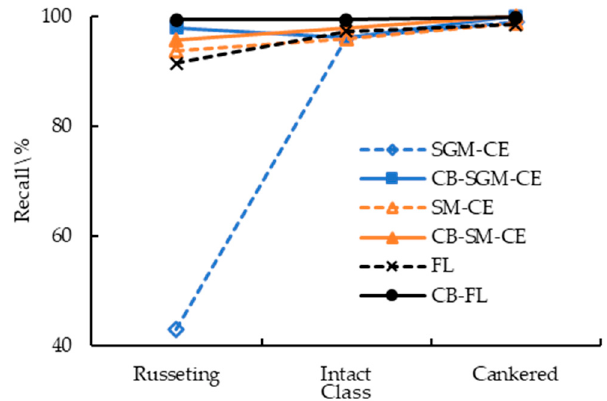
Figure 6. Precision using different loss functions.